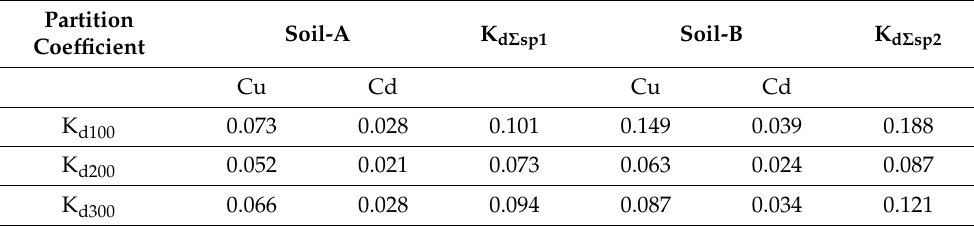
Table 2. The partition coefficient and joint partition coefficient at different initial concentrations of metal ions.